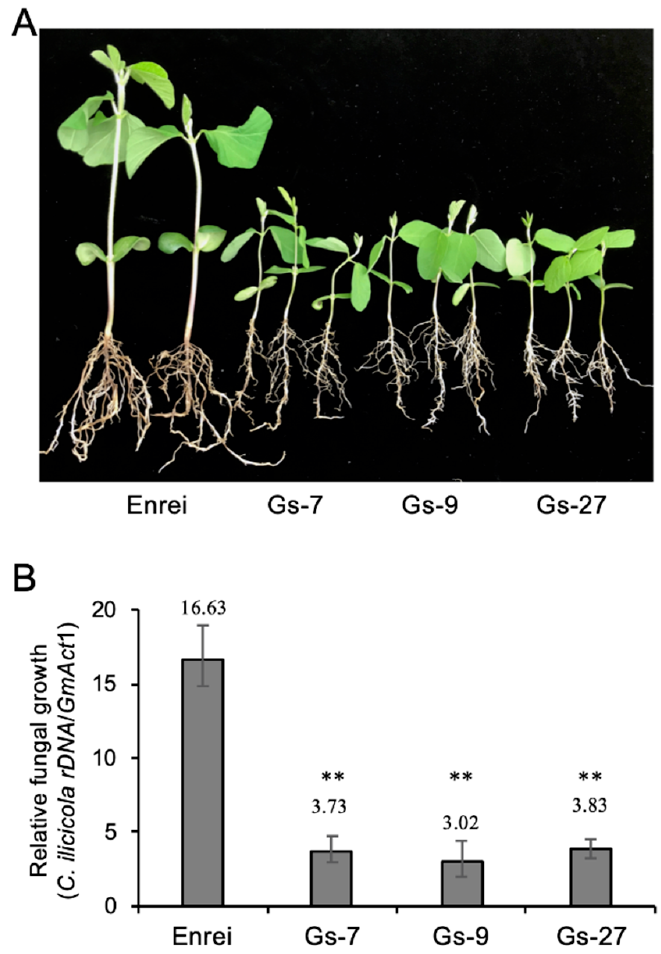
Figure 4. Identification of high resistance to Calonectria ilicicola in wild soybean ( Glycine soja ) lines. ( A ) Images of disease incidence in control soybean cultivar “Enrei” and wild soybeans Gs-7 (JP30157), Gs-9 (JP30159) and Gs-27 (JP36084). ( B ) Relative fungal growth in roots of soybean “Enrei” and the C.